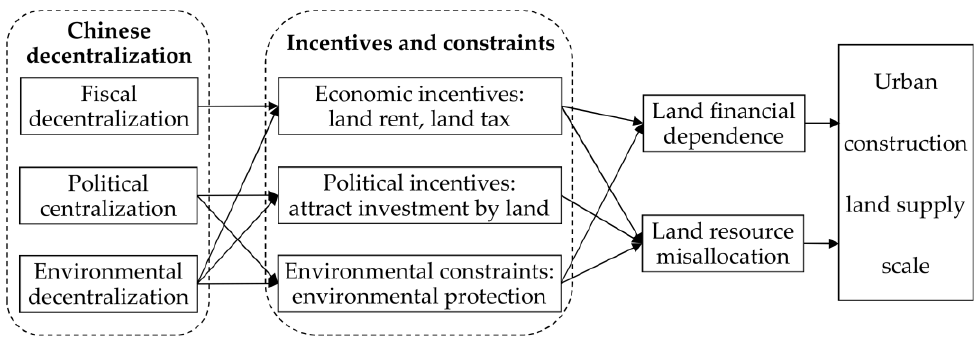
Figure 1. The influence of Chinese decentralization on construction land supply.